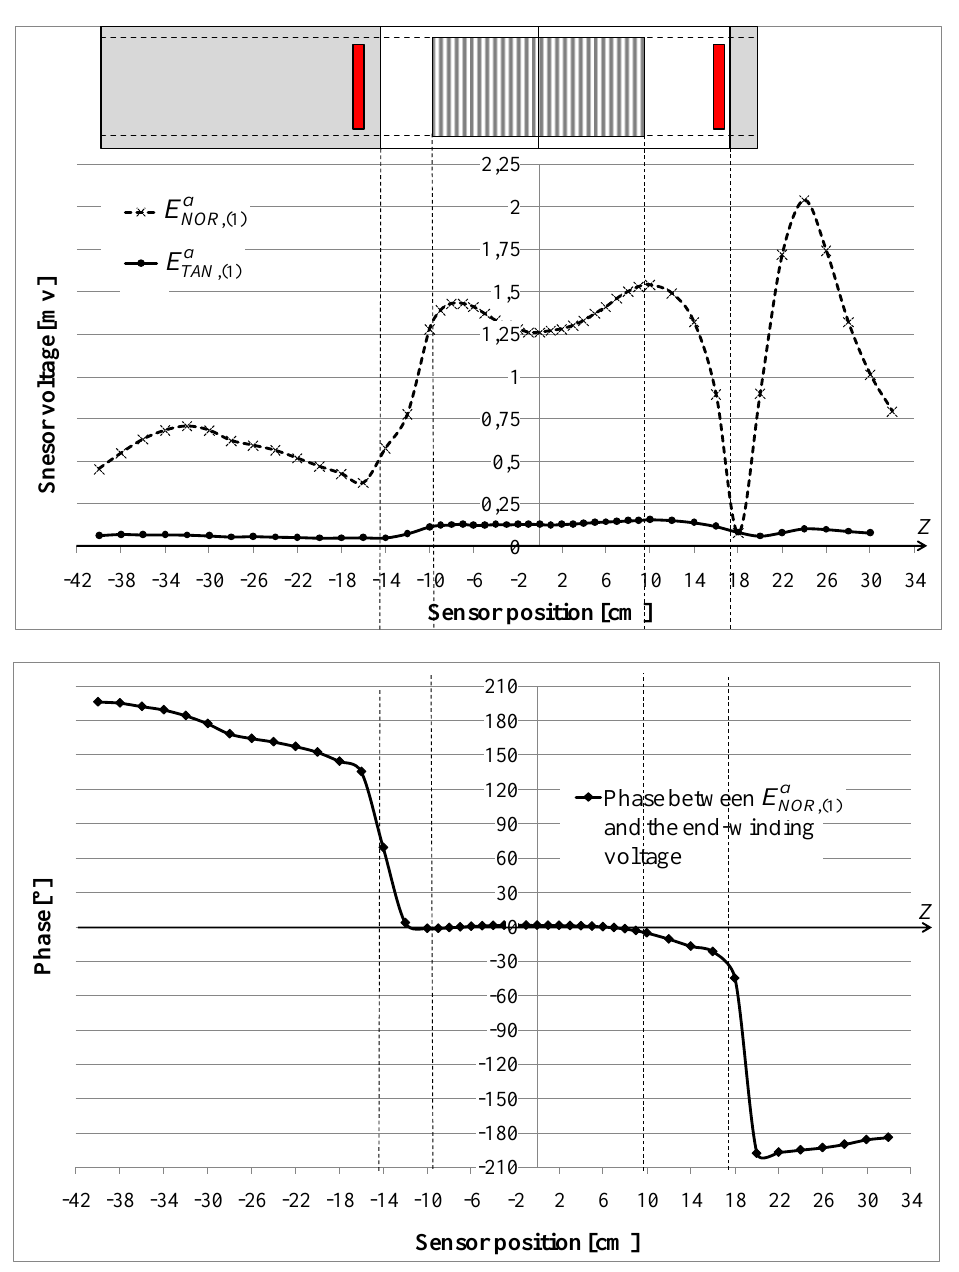
Figure 8. Variations of the normal a components due to the end-windings with Z